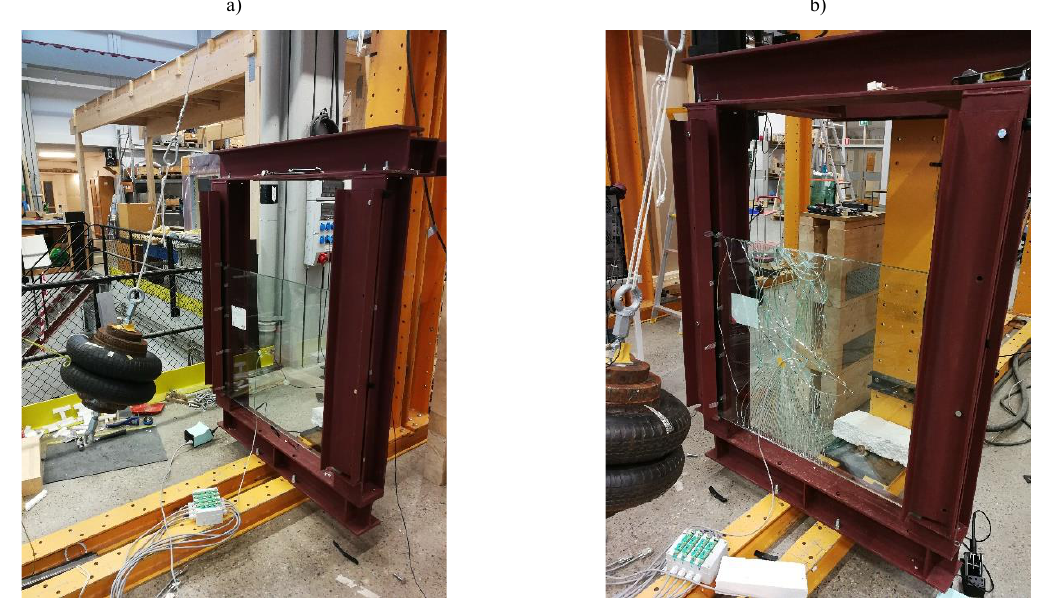
Fig. 3 Soft-body impact test set-up: a) intact specimen, b) specimen with one glass pane in the laminate